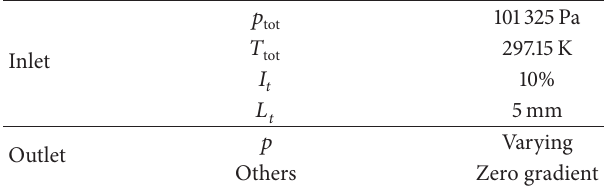
Table 3: Inlet and outlet boundary conditions.